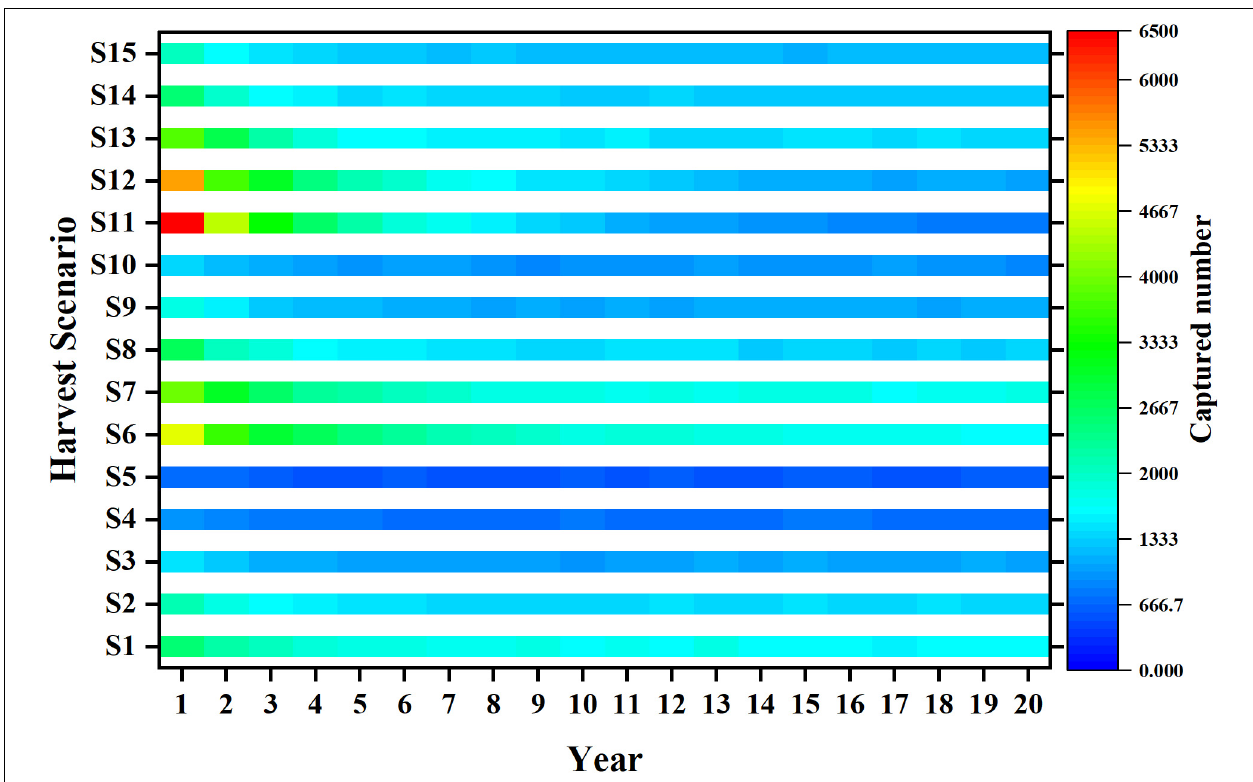
FIGURE 6 | Trends of captured number in different harvest